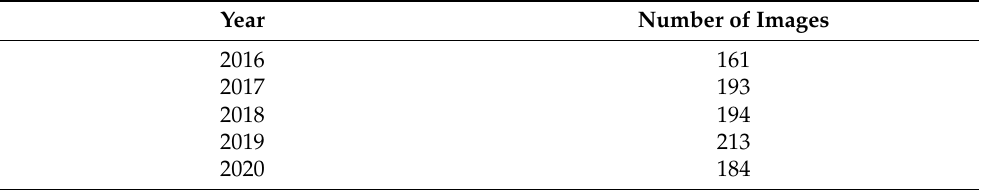
Table 3. Image data information